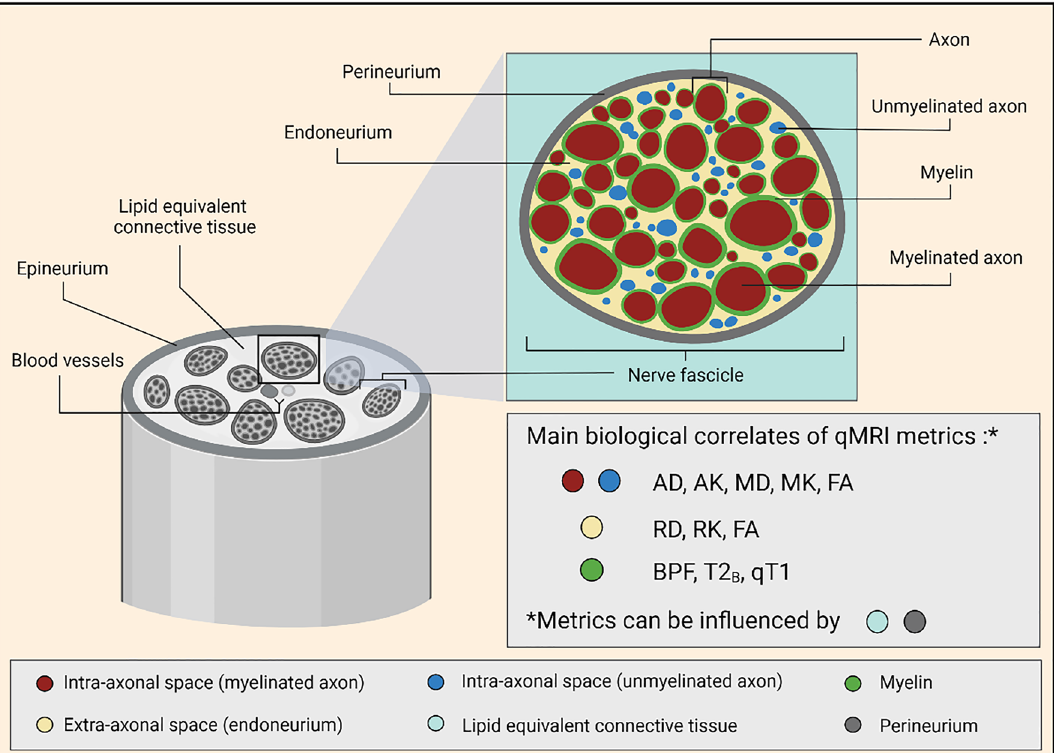
Figure 2. Schematic illustration of the healthy sciatic nerve cross-sectional anatomy at the level of the upper thigh, highlighting the main biological correlates of all qMRI metrics obtained in this study. In the healthy sciatic nerve, the main biological compartments underlying the qMRI metrics are myelin, intra-axonal water (in both myelinated and unmyelinated axons) and extra-axonal space (endoneurium). However, metrics can also be influenced by surrounding tissue compartments (e.g., perineurium, lipid equivalent connective tissue). Note: Although qT1 is known to be sensitive to myelin, the overall macroscopic T1 is rather unspecific, and is likely to be influenced by almost all biological compartments shown (e.g., myelin, amount of intra- and extra- axonal water, as well as potential exchange between the two water